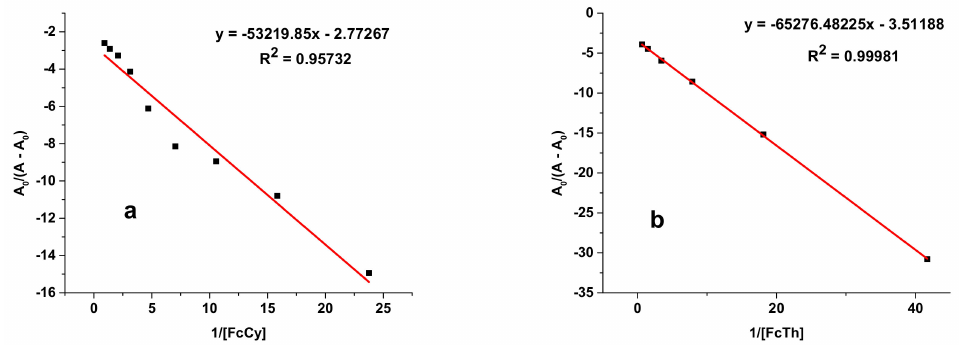
Figure 16. Plots of A 0 /( A − A 0 ) versus 1/[ P ] used to calculate the binding constants of algal compounds with DPPH: ( a ) E 2 ; ( b ) E 3 .